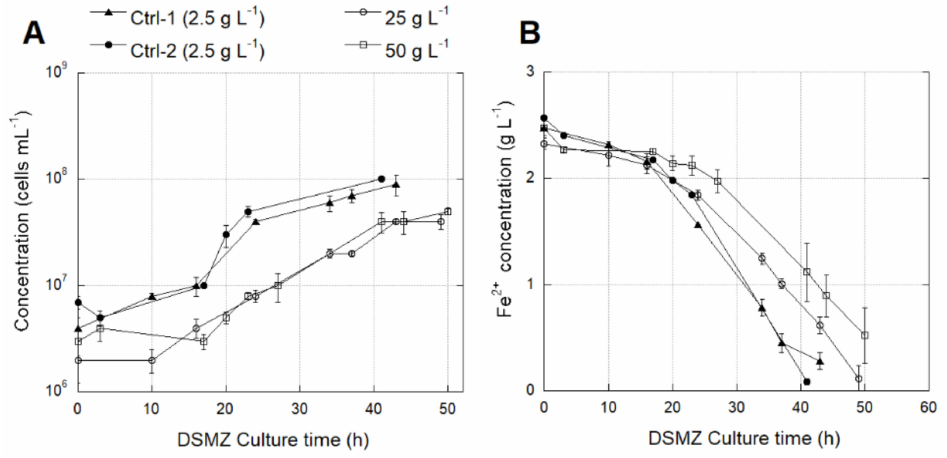
Figure 7. Cell growth ( A ) and Fe 2+ consumption ( B ) of L. ferriphilum type strain DSM 14647 cultured under different SO 42 − concentrations (g L − 1 ). Vertical bars represent the standard deviation (SD) calculated with biological replicates.